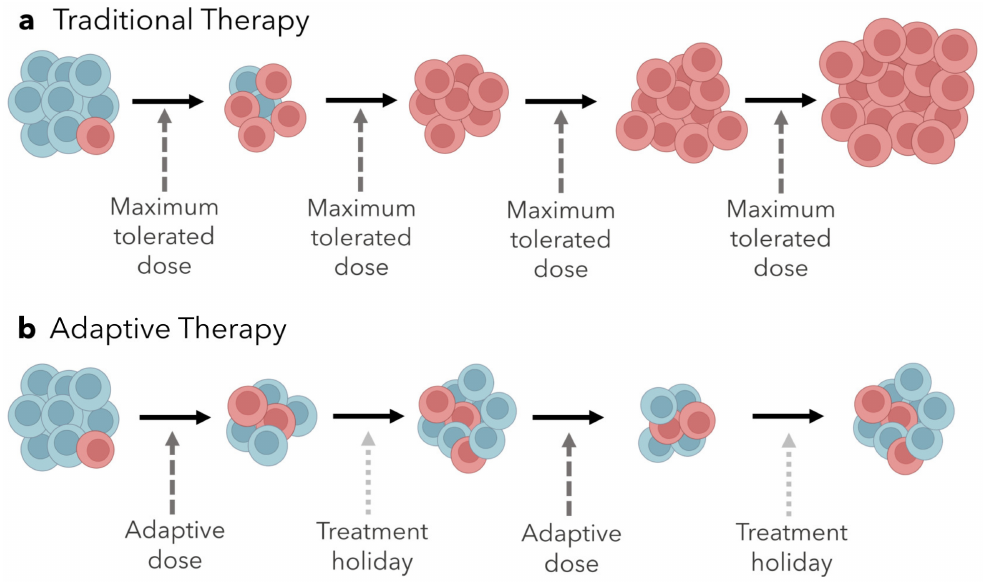
Figure 2. Tumor volume over time with traditional MTD approach compared to adaptive therapy approach. ( a ) Treating a tumor with the maximum tolerated dose initially relieves tumor burden until treatment-resistant cells evolve, eventually resulting in the competitive release of resistant cells and treatment failure. ( b ) Including treatment holidays to allow treatment-sensitive tumor cells to proliferate maintains competitive suppression of treatment-resistant tumor cells, resulting in a controllable tumor